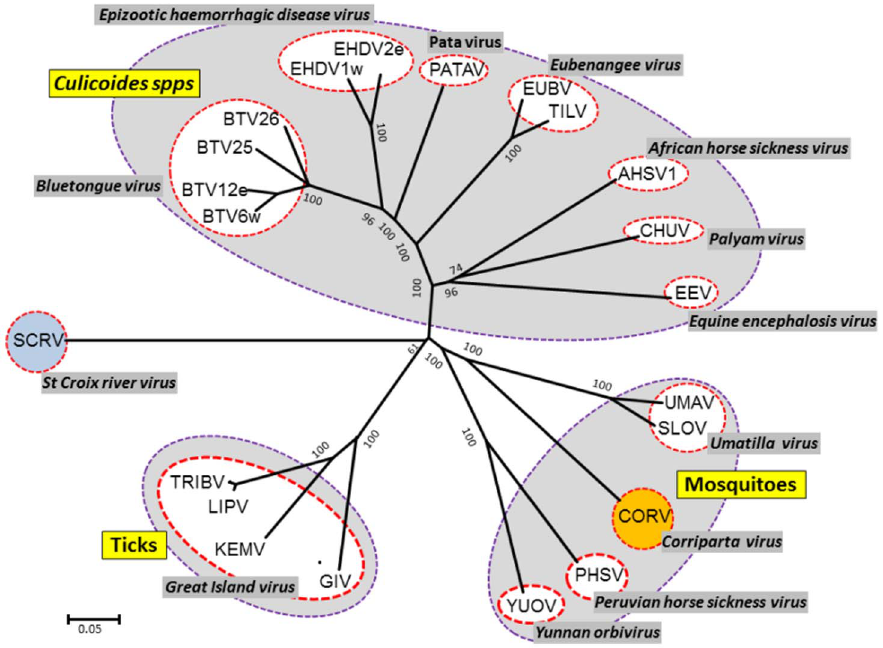
Figure 3. Unrooted neighbour-joining for orbivirus polymerase VP1(Pol) proteins. An unrooted NJ phylogenetic tree for orbivirus VP1(Pol) proteins was constructed using a p-distance algorithm and pairwise deletion parameters, as indicated in Figure 1. The CORV-MRM1 isolate characterised in this study is indicated in red font in amber coloured circle. Full names of virus isolates and accession numbers of polymerase sequences used for comparative analysis are listed in Table S1 (supplementary data). ‘e’ and ‘w’ after serotype number indicate eastern and western topotype strains, respectively.